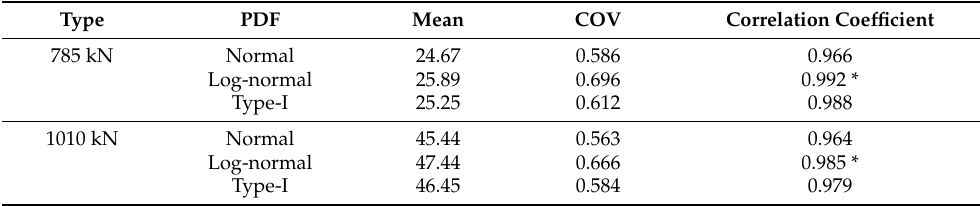
Table 18. Probabilistic characteristics for 785 kN model and 1010 kN